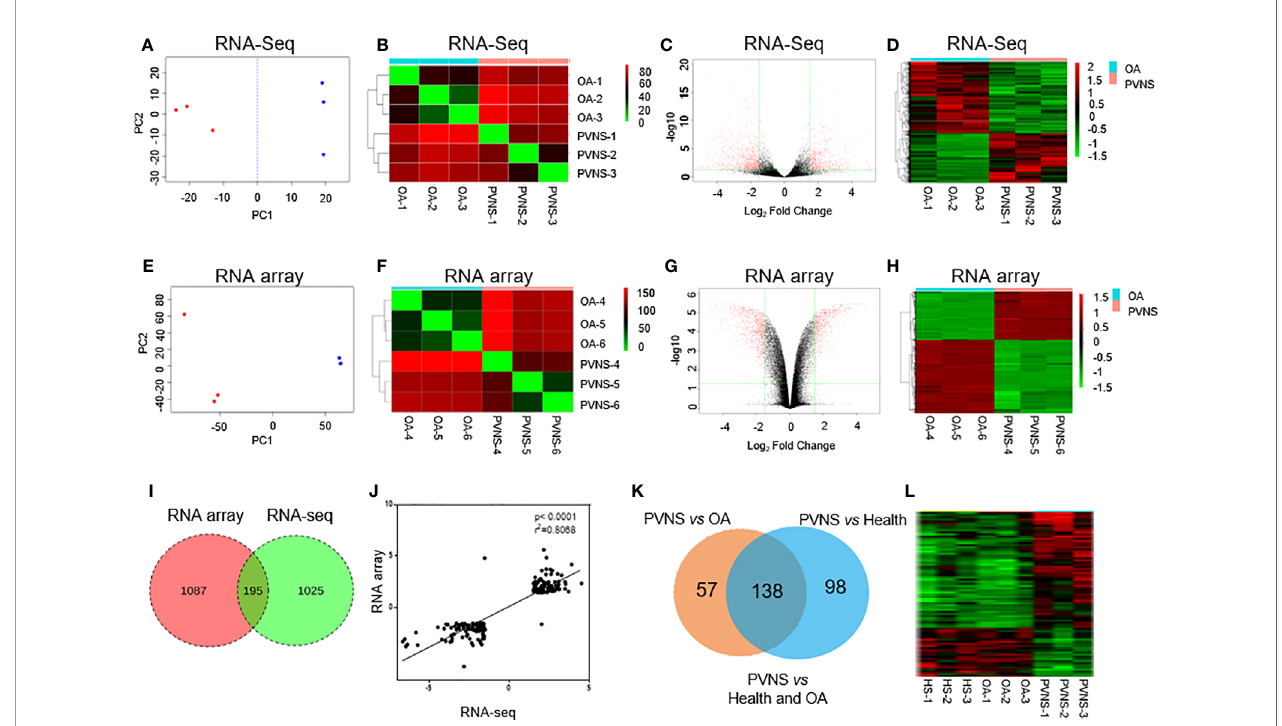
FIGURE 1 | Global analysis of gene expression in pigmented villonodular synovitis (PVNS) compared to osteoarthritis (OA). (A, E) Principal component analysis of gene expression patterns of all genes in both PVNS and OA patient samples. Both the samples constitute two clusters. (B, F) Correlation heatmap of PVNS and OA transcriptomes. (C, G) Volcano plots of host gene expression from the RNA sequencing (RNA-Seq) analysis of PVNS and OA. (D, H) Heatmap of differentially expressed genes (DEGs) from both PVNS and OA samples; samples were clustered due to their similarity in gene expression. The color key indicates the relative gene expression intensity. (I) Venn diagram of DEGs reported in RNA-Seq and RNA microarray analyses. Only genes with q-value< 0.01, fold change >2, and fragments per kilobase of transcript per million mapped reads >1 were included. (J) Gene expression changes of common DEGs found by RNA-seq compared to RNA microarray. (K, L) Venn diagram of DEGs of PVNS vs. OA and PVNS vs. Health (GSE143514). Only genes with q-value< 0.01, fold change >2, and fragments per kilobase of transcript per million mapped reads >1 were